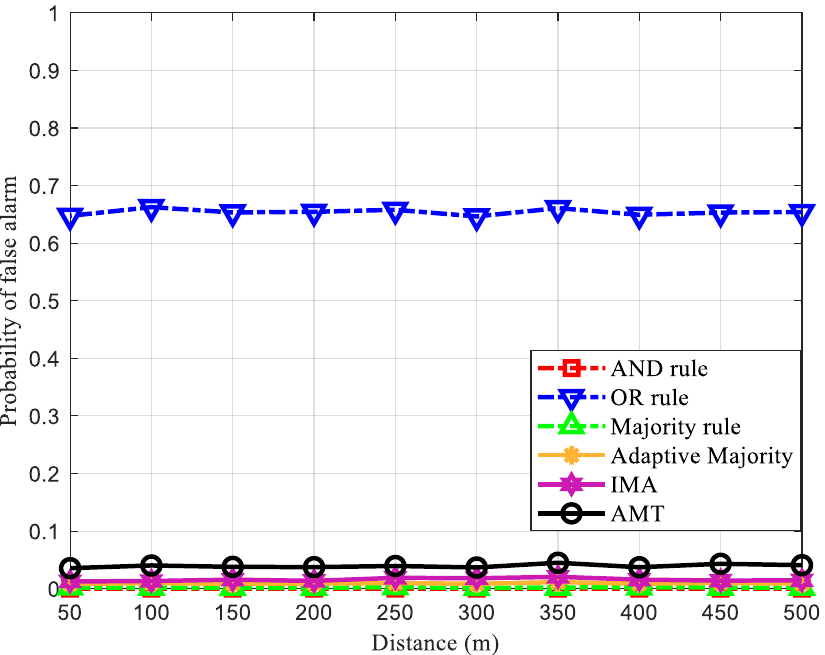
Figure 4. Investigation of the performance of each cooperative spectrum sensing technique with comparison of Q f as a function of distance.